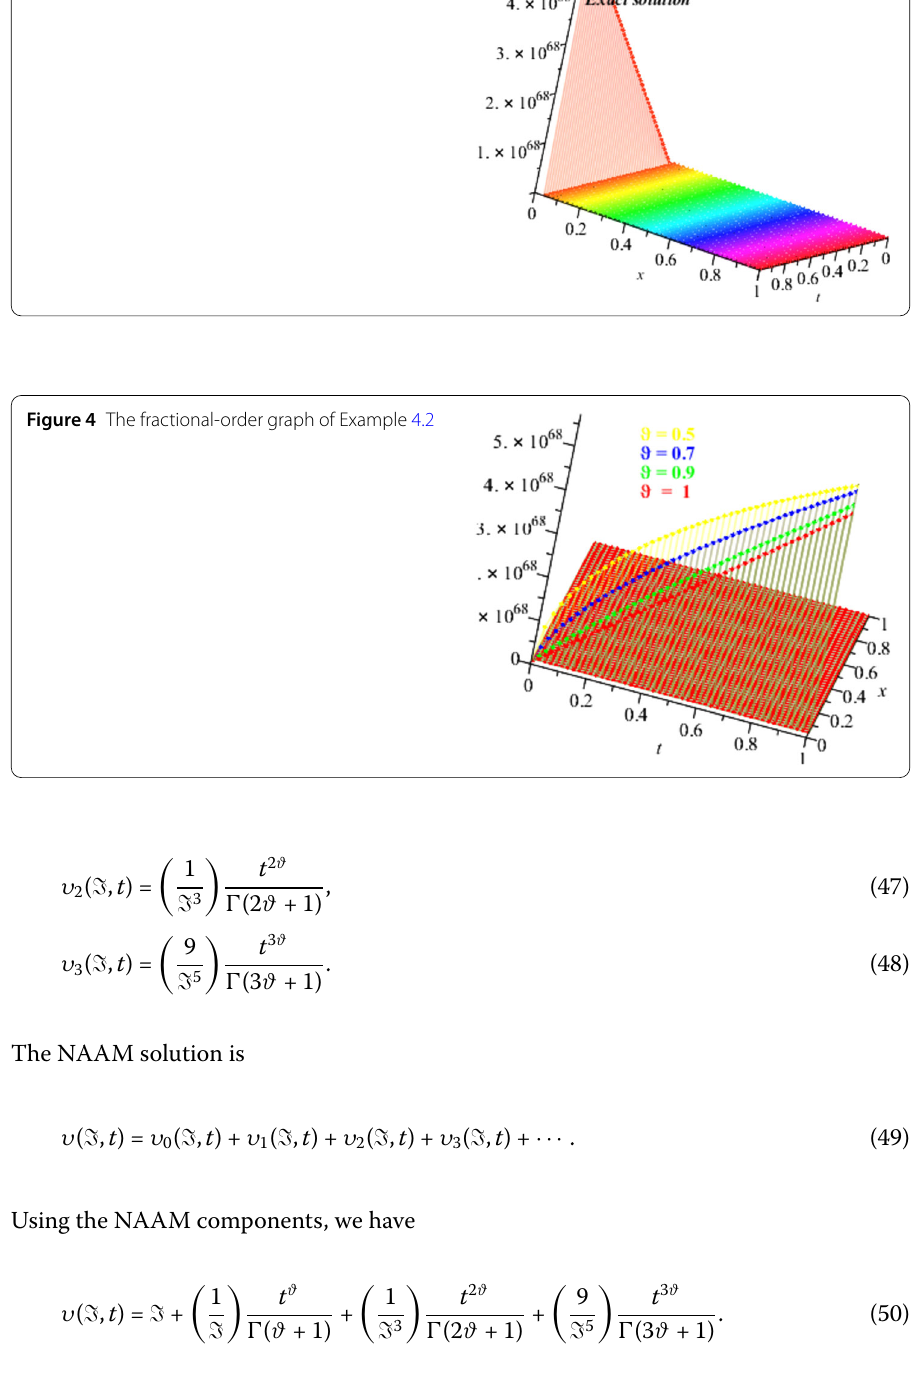
Figure 3 The exact and NAAM solution graphs of Example 4.2